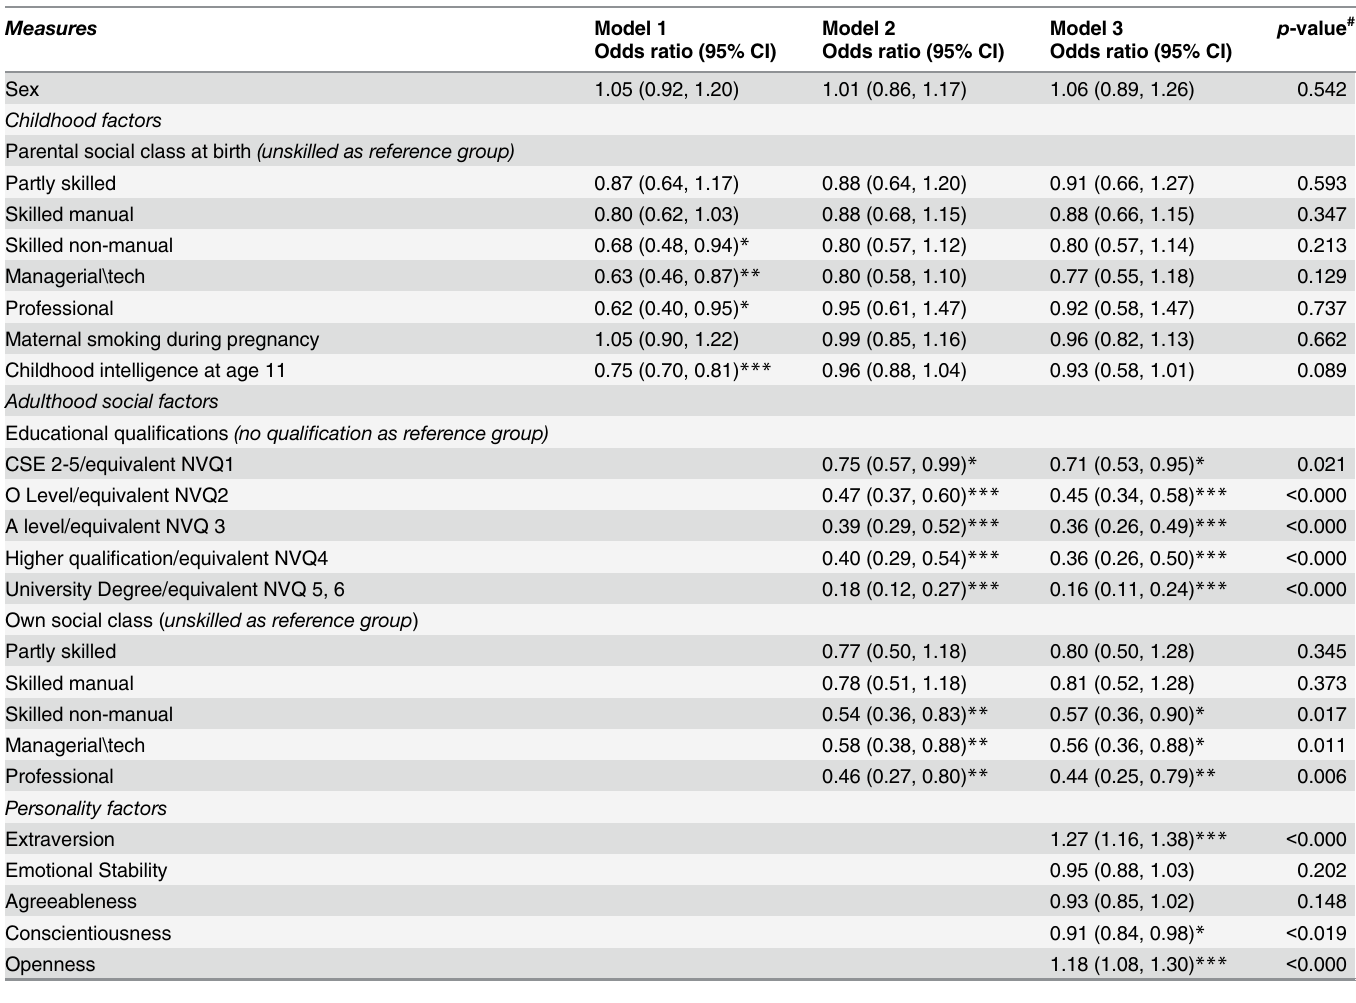
Table 3. Odds ratios (95% CI) for current tobacco use at age 50, according to childhood and adulthood factors.